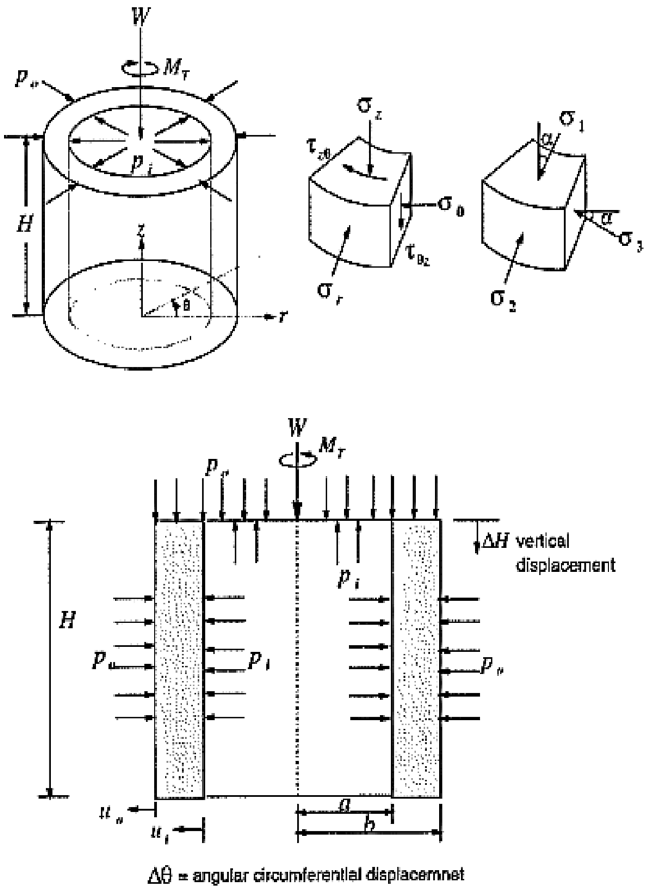
Figure 6. Load and stress conditions for hollow cylinder test (After Hight et al. 8